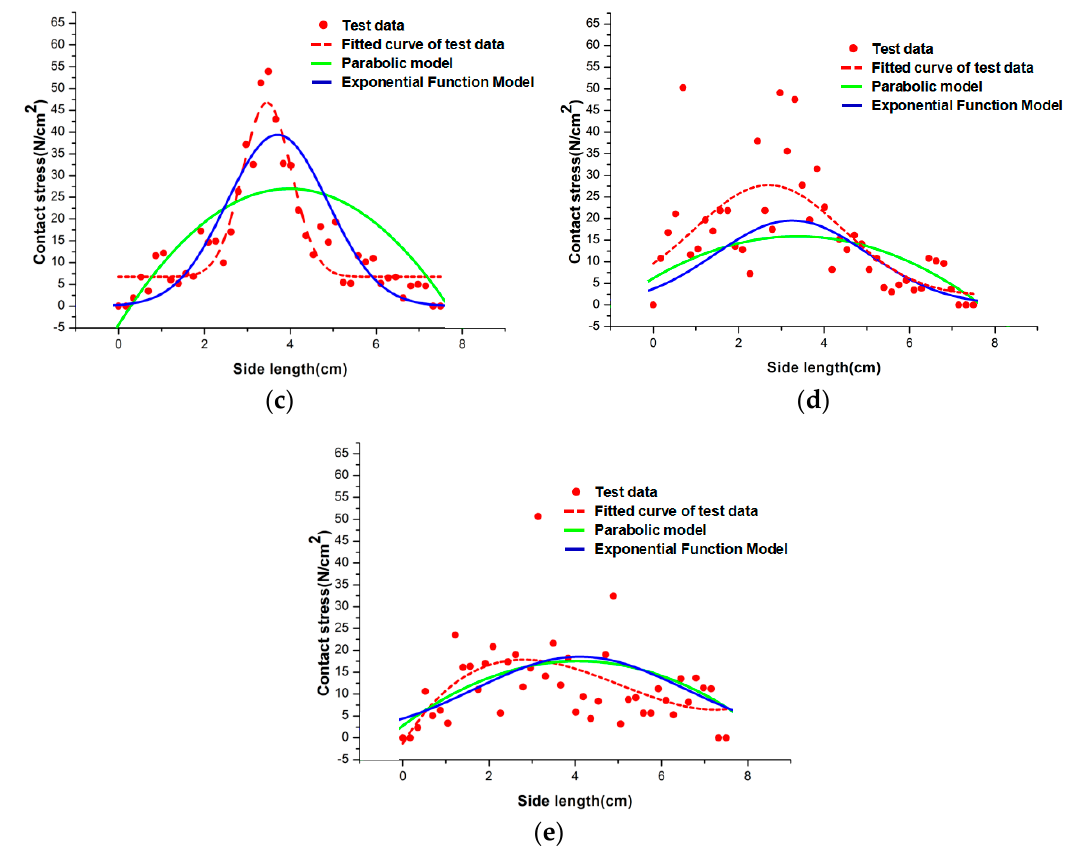
Figure 10. Comparison of contact stress values and experimental values of di ff erent models: ( a ) aspect ratio of 18.75 ( λ = 18.75); ( b ) aspect ratio of 15 ( λ = 15); ( c ) aspect ratio of 9.375 ( λ = 9.375); ( d ) aspect ratio of 7.5 ( λ = 7.5); and ( e ) aspect ratio of 6.25 ( λ = 6.25).